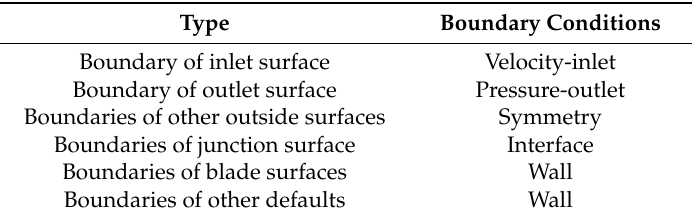
Table 1. Boundary conditions.